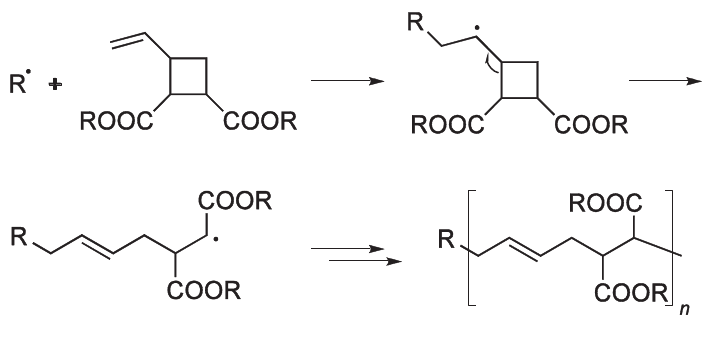
Figure 4. The RROP of a substituted vinyl cyclobutane.